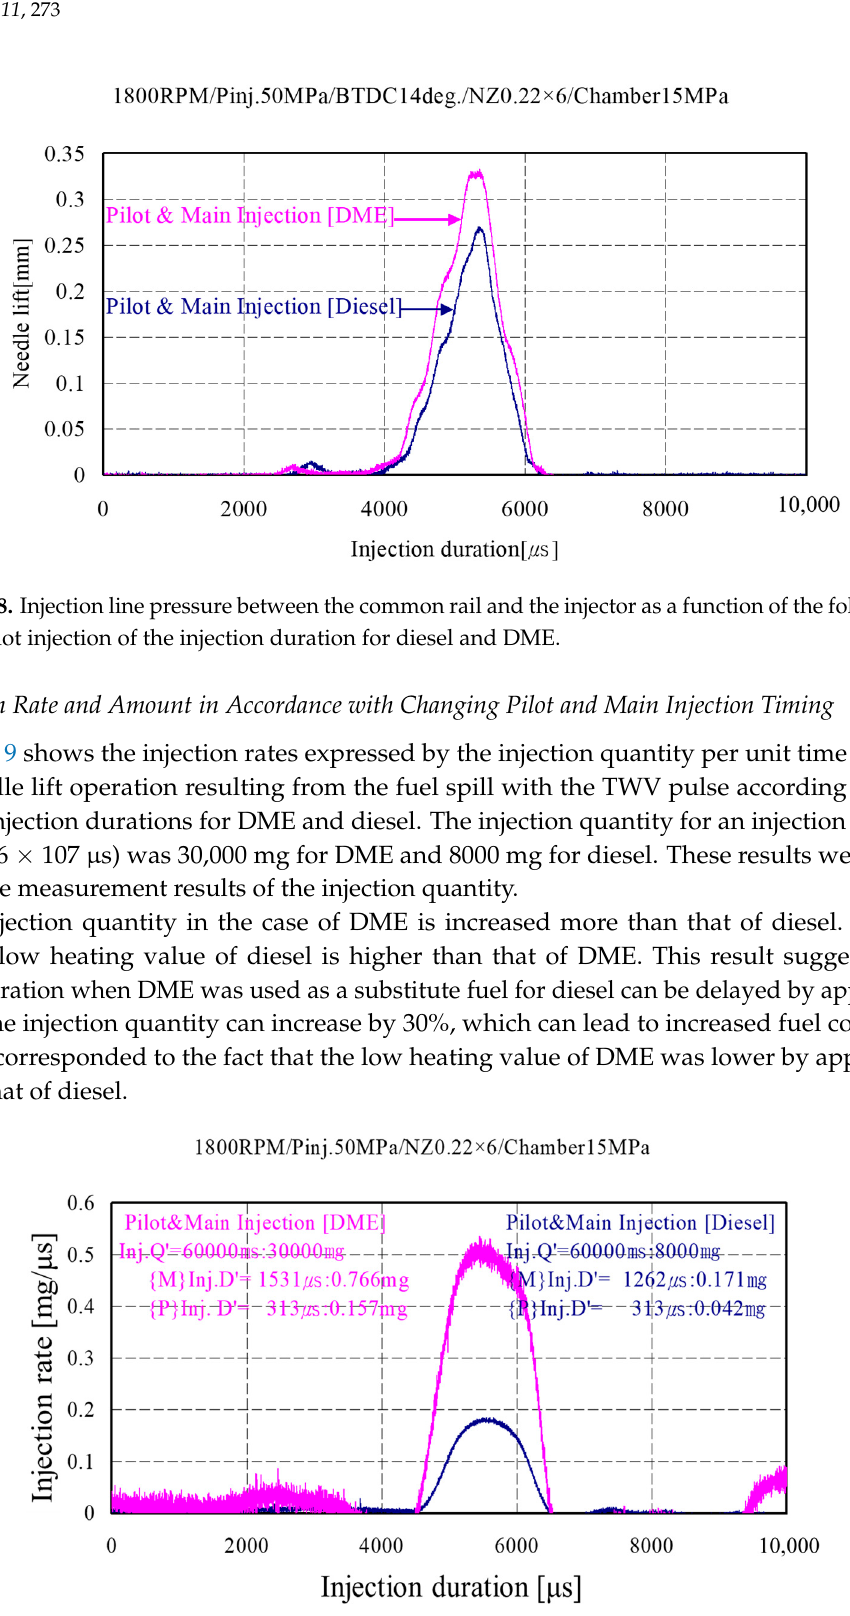
Figure 7. Injection line pressure between the common rail and the injector as a function of the following: without pilot injection of the injection duration for diesel and DME.